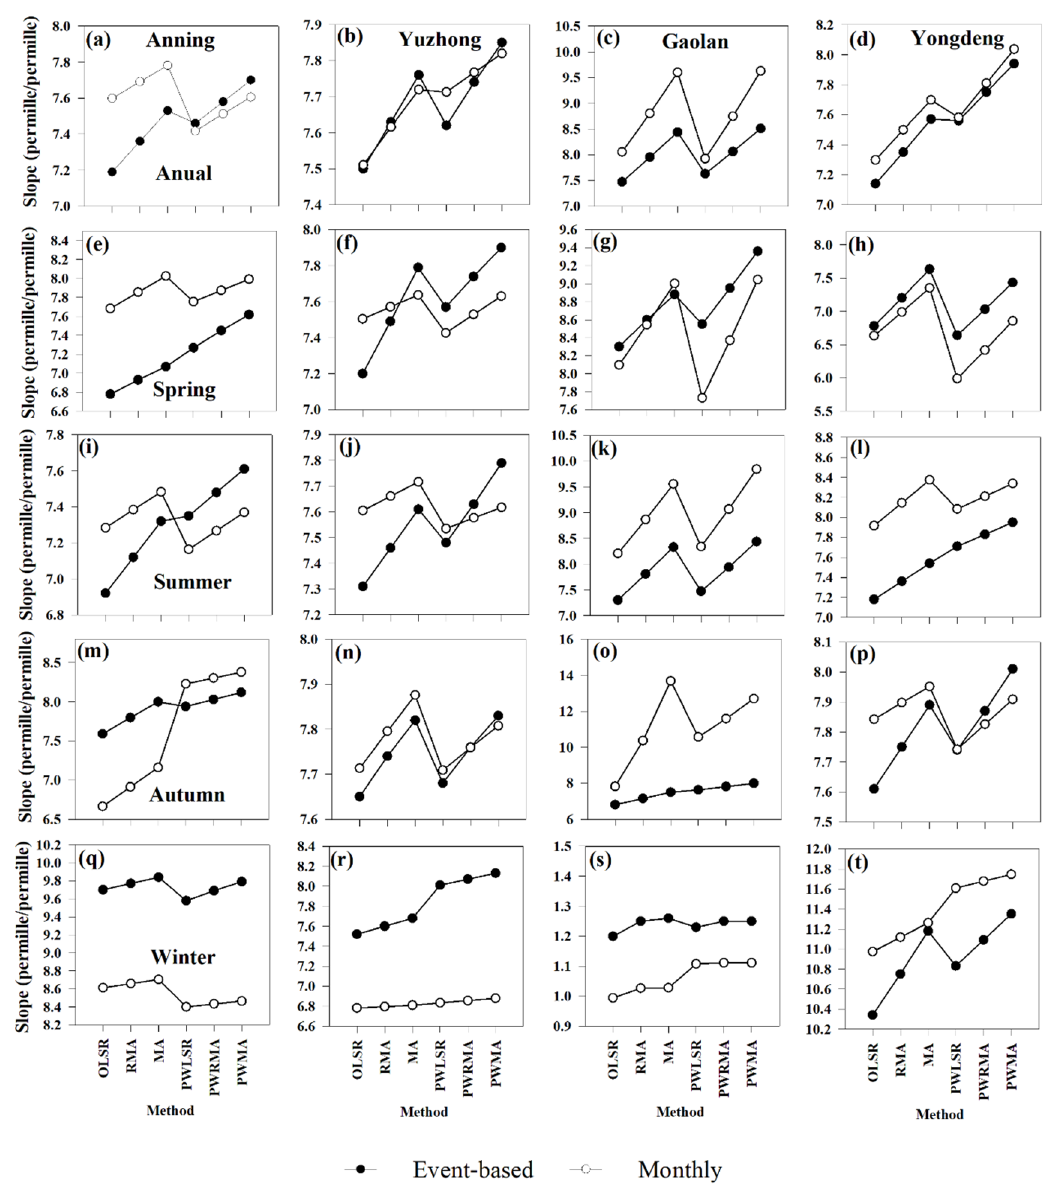
Figure 7. LMWL slopes using event-based and monthly data based on a seasonal basis using six regression methods for each sampling station in Lanzhou from 2011 to 2014.